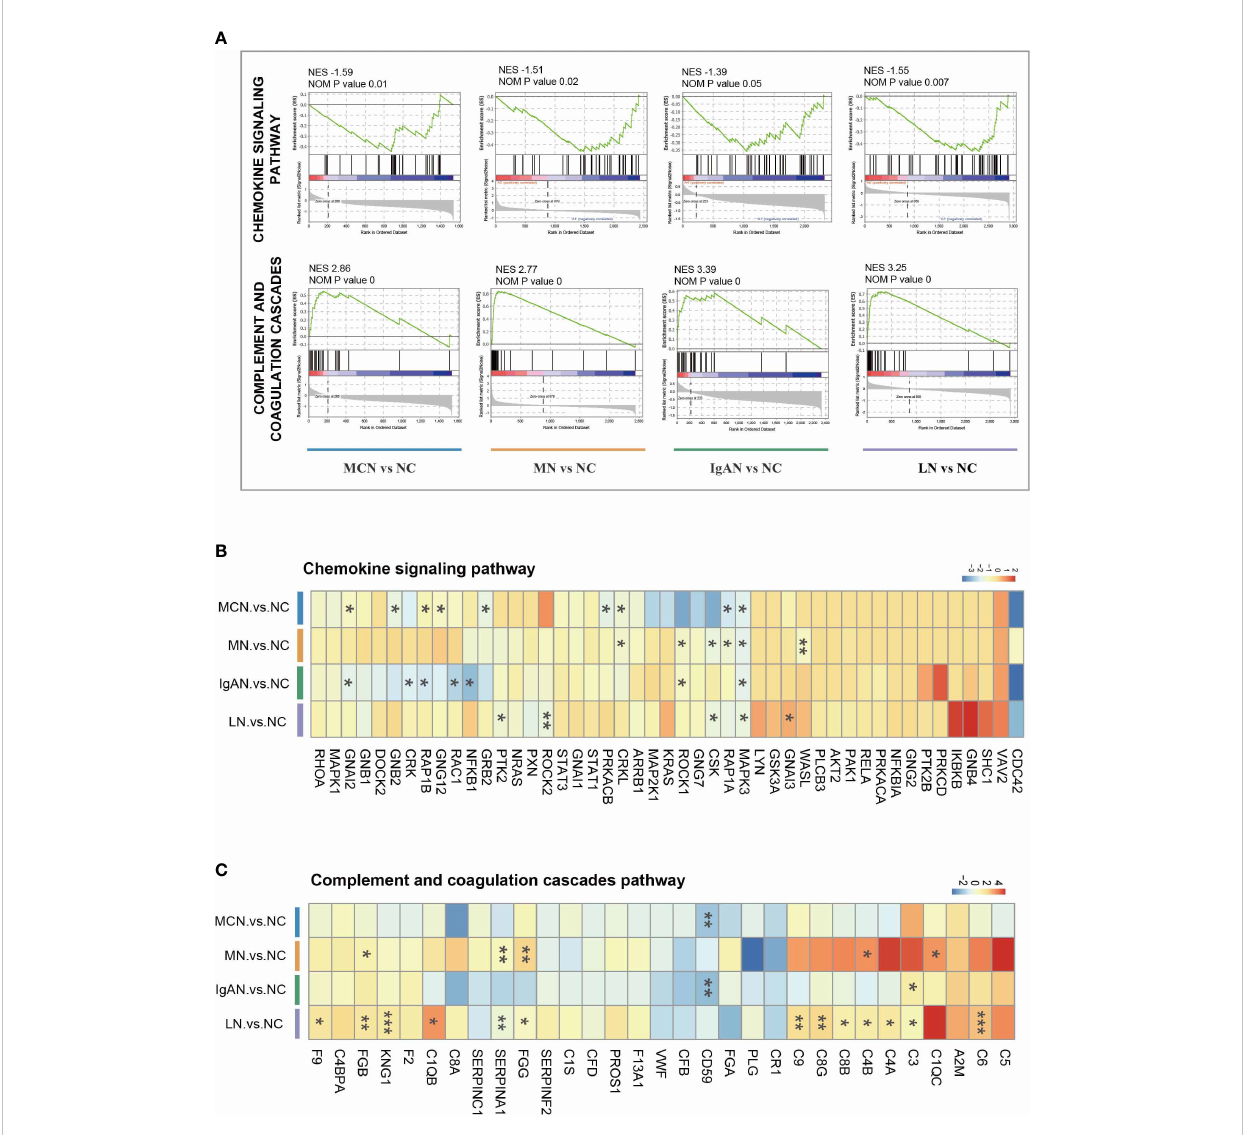
FIGURE 3 The characteristic of two immunity-related pathways in four GNs diseases. (A) GSEA enrichment plots of representative pathways in each cluster. (B, C) The heatmap of the fold-change of identi fi ed proteins involved in representative pathways. Versus NC group; * P < 0.05 , ** P < 0.01, *** P <